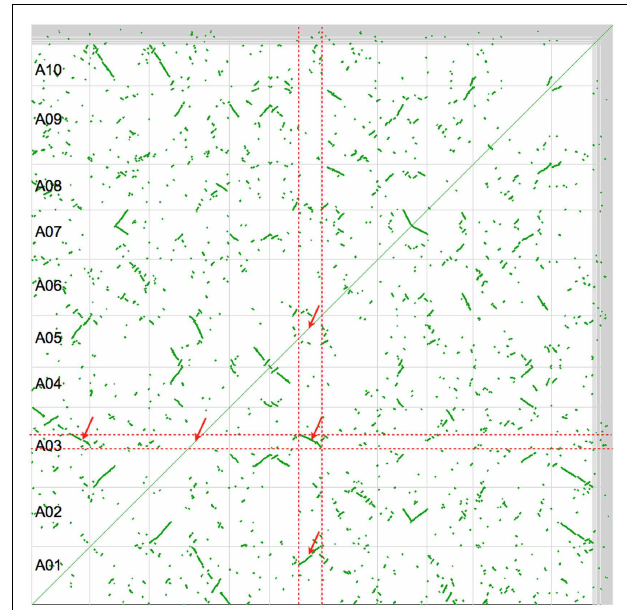
FIGURE 2 | Syntenic dotplot of self–self Brassica rapa comparison. Horizontal and vertical gray lines separate chromosomes. Green dots are syntenic gene pairs identified through collinearity. Red dashed lines band and red arrows point to large intra-genomic syntenic signal showing a 3:3 syntenic relationship. Results may be regenerated: